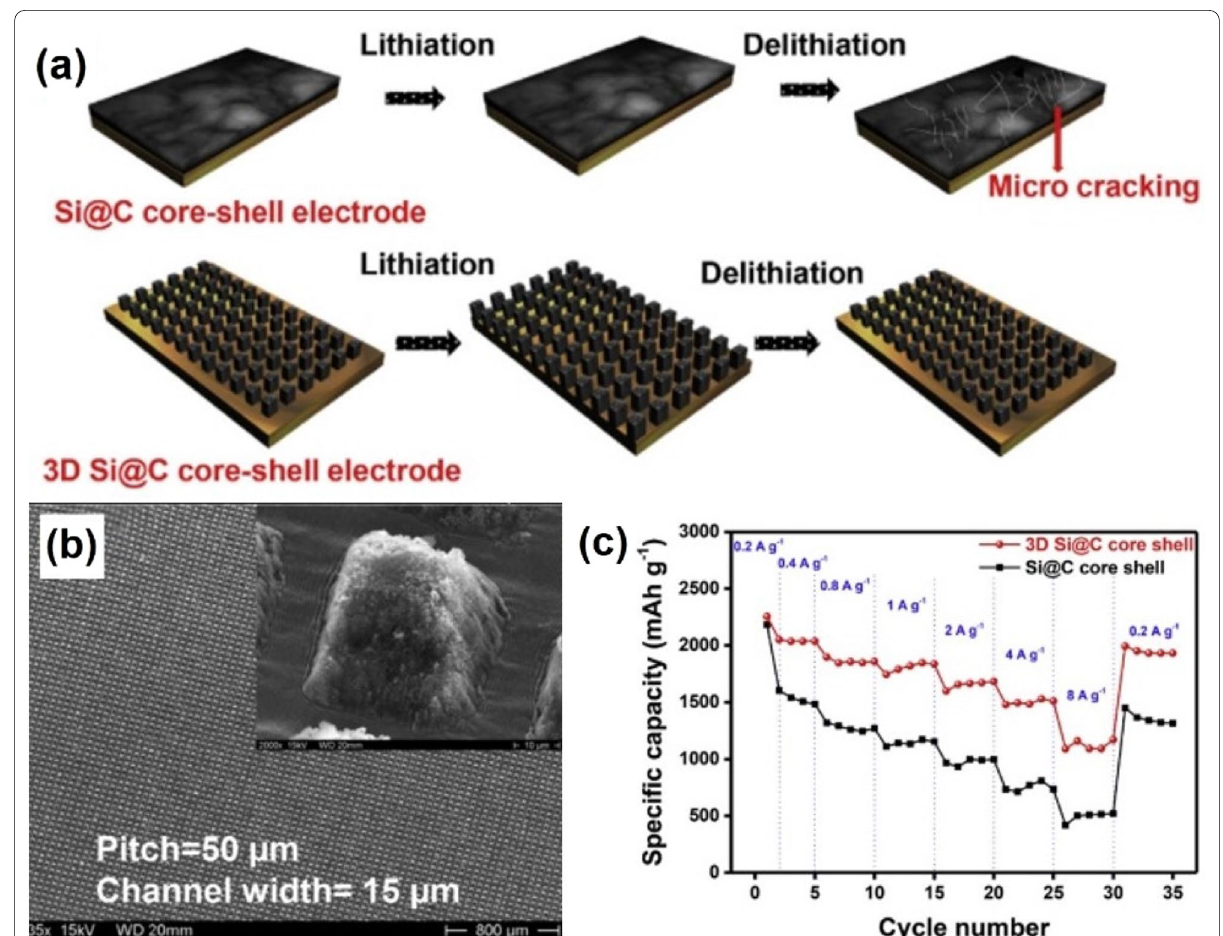
Fig. 4 a Schematic illustration of the 3D Si@C core–shell electrode. b SEM images of the 3D Si@C core–shell electrodes. c Rate performances of the Si@C and 3D Si@C core–shell cells at various current densities of 0.2, 0.4, 0.8, 1, 2, 4, 8, and 0.2 A/g (cut‑off voltage: 0–2 V)